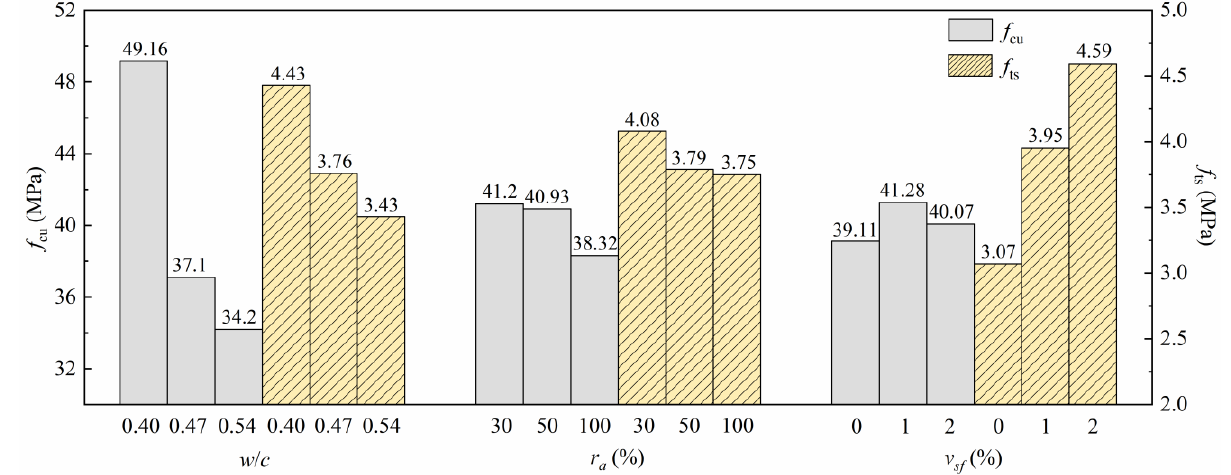
Figure 12. Relationships between various factors and mechanical properties.